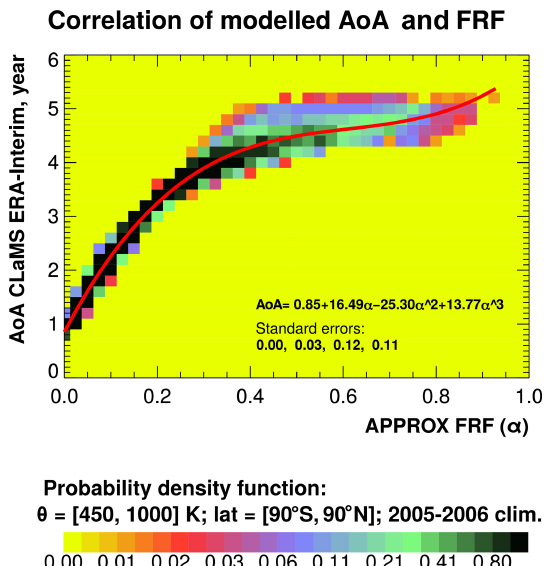
Figure A1. Relationship between CLaMS AoA and FRF. Relation- ship between CLaMS FRF and AoA for the methods of AoA trend estimation using stationary approximation. FRF is defined from the climatological 2005–2006 CLaMS-simulated CH 4 , and AoA is the climatological 2005–2006 from CLaMS simulations. The consid- ered correlated region is between 450–1000K and 90 ◦ S–90 ◦ N. The colour bar represents the probability density function. The red line is a third-order polynomial fitting function.